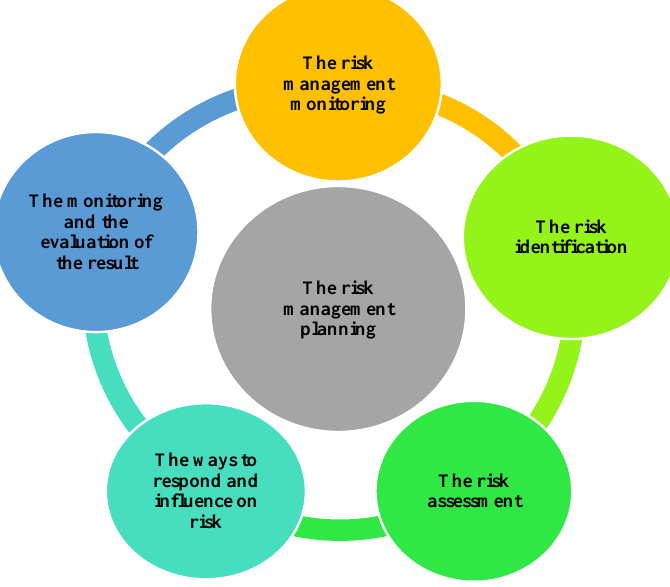
Figure 5. The scheme of an integrated risk management system of the investment